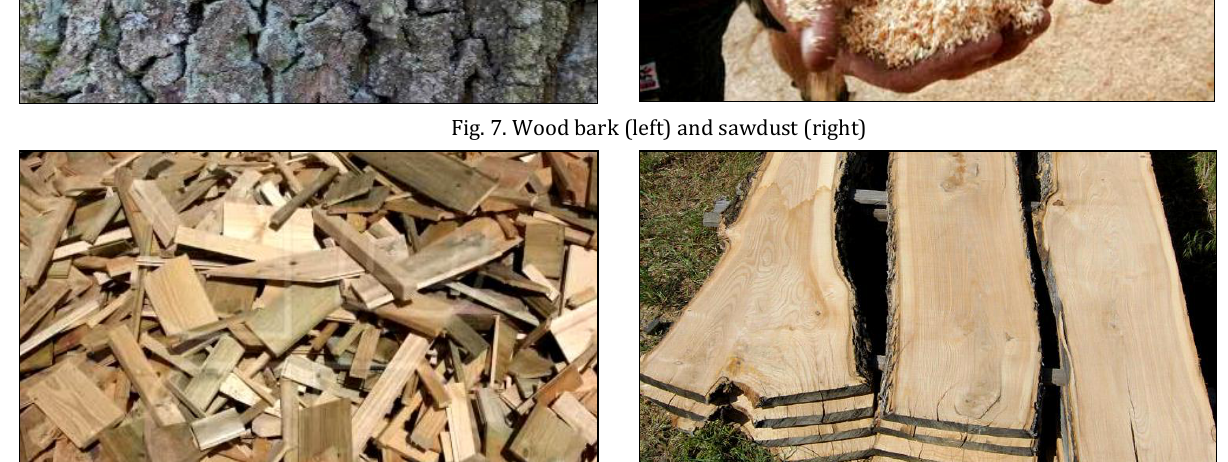
Fig. 7. Wood bark (left) and sawdust (right)